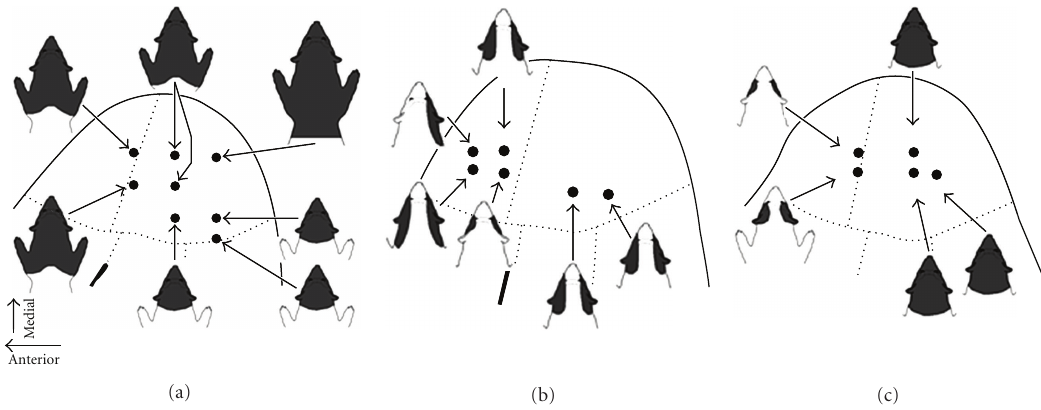
Figure 5: Distribution of somatosensory receptive fields in core auditory cortex of early hearing-impaired ferrets. For each of the surface plots for the di ff erent hearing-impaired animals (a–c), the associated schematic of the ferret’s body surface shows the somatosensory receptive field(s) (shaded dark gray) encountered in that recording penetration. Note that in each case somatosensory receptive fields were located on the anterior aspect of the body (head, neck, and forelimb) and that they were predominantly bilateral (included both ipsi- and contralateral body surface).